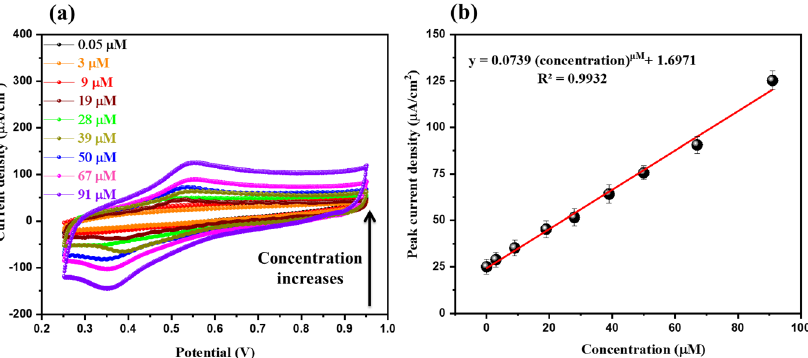
Figure 5. CV patterns ( a ) of S@rGO/GCE in various concentrations of acetaminophen (0.05, 3, 9, 19, 28, 39, 50, 67, 91 µM) in 0.1 M PBS of pH 7.0 (fixed scan rate =50 mV/s). Calibration curve between 28, 39, 50, 67, 91 µ M) in 0.1 M PBS of pH 7.0 (fixed scan rate = 50 mV/s). Calibration curve between peak current density response and acetaminophen concentration ( b ). peak current density response and acetaminophen concentration ( b